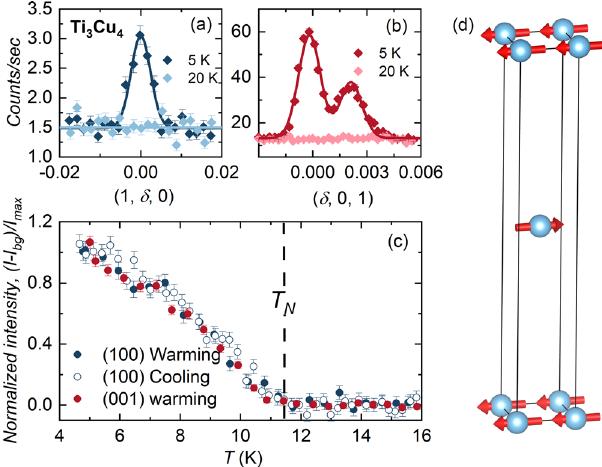
Fig. 3 Elastic neutron scattering. Rocking curve measurements on the ( a ) (100) and ( b ) (001) positions at temperatures T = 20 and 5 K reveal the formation of magnetic Bragg peaks. Solid lines are fi ts to a Gaussian lineshape. Note that the maximum divergence in the orthogonal direction for the rocking curves was of order 0.02%. c An order parameter, constructed by measuring the intensity of the (001) and (100) Bragg peaks as a function of temperature, con fi rms that the magnetic order onsets at the Néel temperature T N = 11.3 K. d The periodicity (red arrows) of the magnetic order as determined by symmetry analysis for Ti2 at the 2 b Wyckoff site (blue spheres) in the I 4/ mmm space group. Error bars, where indicated, represent one standard deviation.